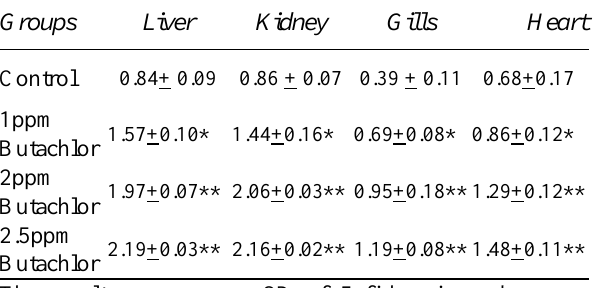
Table 1: The formation of Malondialdehyde (nmol/mg protein) in the liver, kidneys, gills and heart of Clarias gariepinus exposed to Butachlor Groups Liver